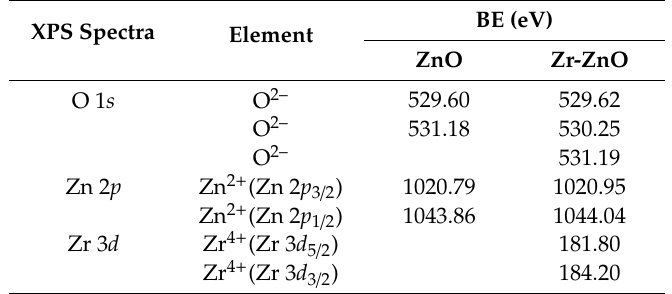
Table 3. The electron binding energy (BE) of the ZnO and Zr–ZnO catalysts.